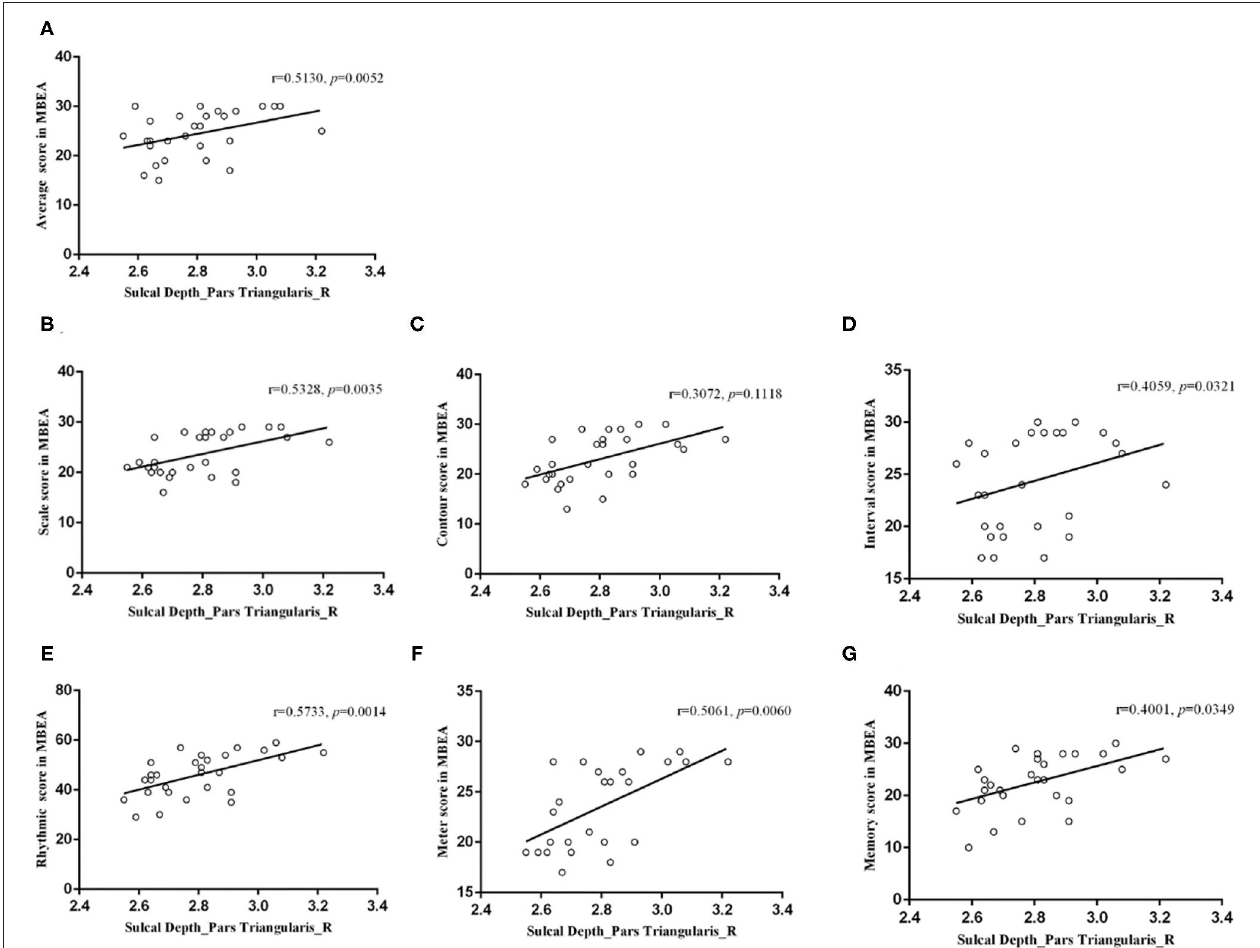
FIGURE 7 | Correlations between the mean sulcal depth in the right pars triangularis and the MBEA test and subtest scores. In the right pars triangularis gyrus, the mean sulcal depth was positively correlated with the mean MBEA score (A) , pitch score (B) , interval score (D) , rhythmic score (E) , meter score (F) , and memory score (G)